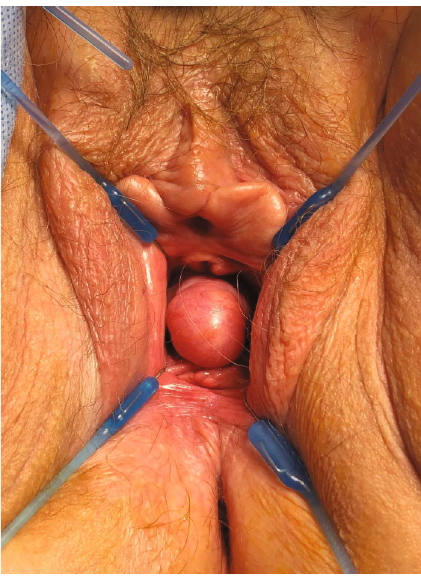
Figure 1: Anterior vaginal wall hernia.